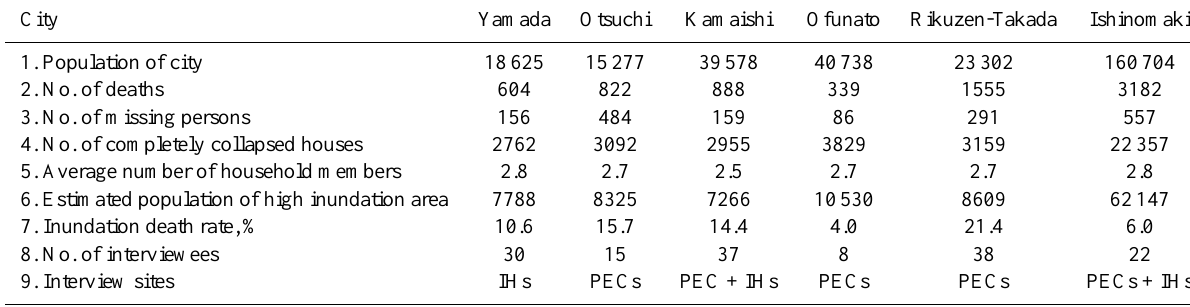
Table 3. Information about the six cities where the interviews were performed in this study. City